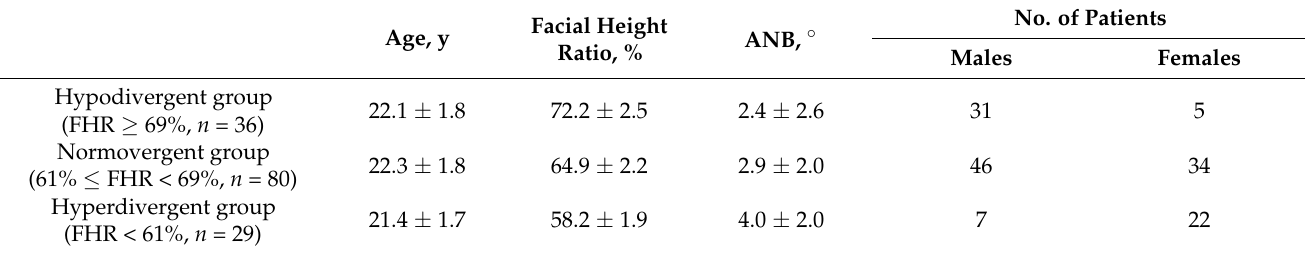
Table 2. Patient characteristics (mean ± standard deviation or counts).